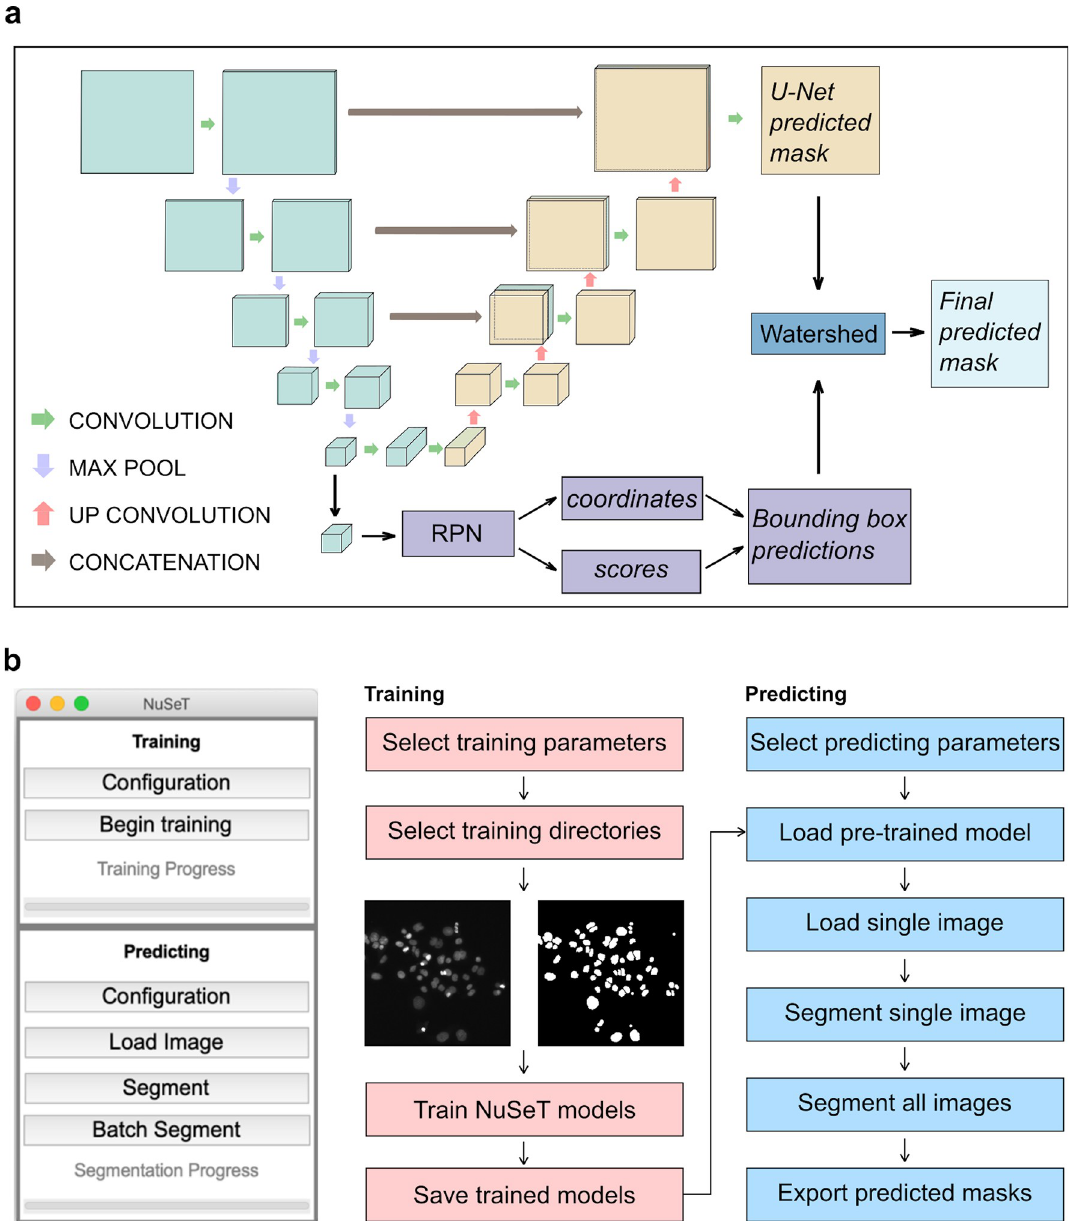
Fig 1. Pipeline for segmenting nuclei with NuSeT. ( A ) Deep-learning model structure of NuSeT. The inputs of the model are gray scale images with different sizes. The outputs are binary masks with the same size as inputs, with predicted foreground regions as Ones and background regions as Zeroes. The model combines U-Net (gray and orange) and Region Proposal Network (purple), which performs nuclei segmentation and detection separately. The results are then merged and processed by watershed (dark blue) to generate final predictions. ( B ) Outlook of NuSeT Graphic User Interface(GUI), and example training and predicting pipelines using NuSeT GUI. with our RPN-U-Net fusion. In step two, this coarse prediction is used to perform foreground normalization on test images before they are fed into the model for a second pass (Fig 2B). Compared with whole-image normalization, the two-step foreground normalization approach is relatively robust to illumination differences, cell-density variations, and image artifacts and